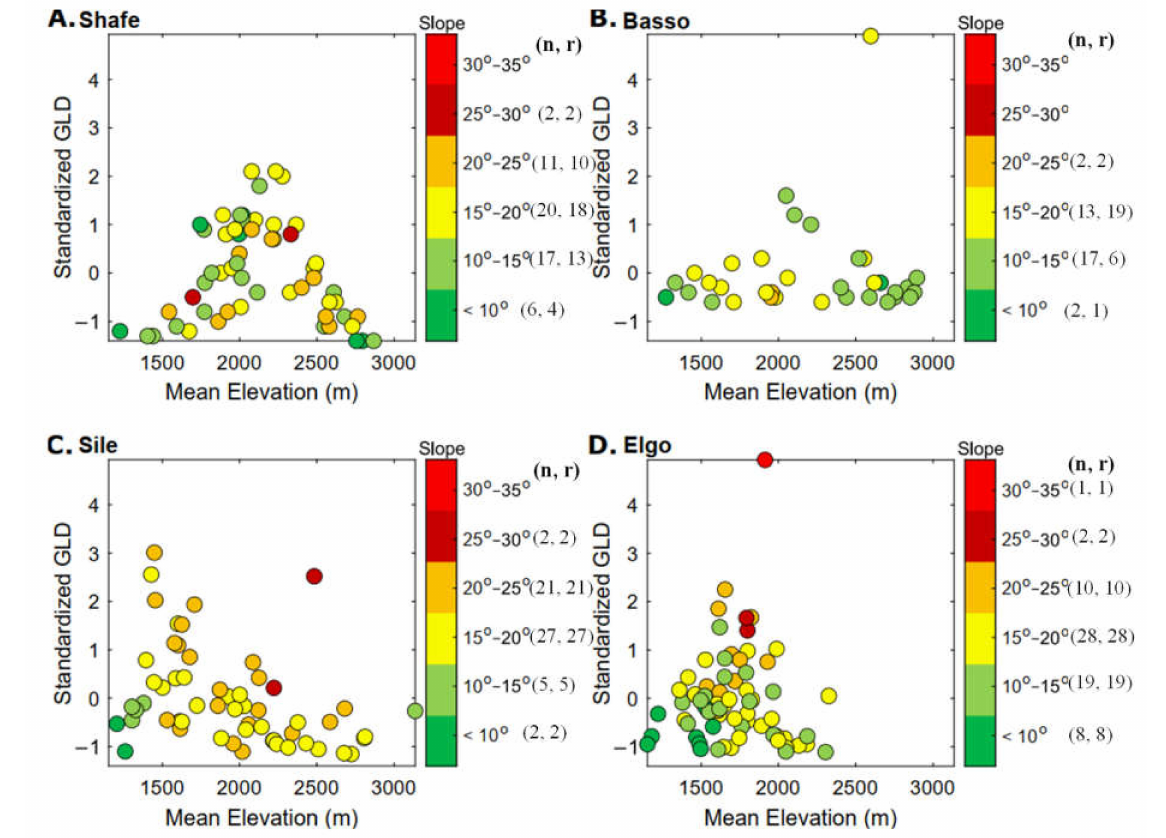
Figure 6. Relationships between GLD, mean elevation and mean slope angle for each sub-catchment of the four study catchments. Symbols are colored based on slope angle. n represents number of sub- catchments of the stated slope angle category in degrees, and r represents number of sub-catchments of each slope angle category in the rejuvenated landscape. In Sile and Elgo, only sub-catchments in rejuvenated landscape are affected by gully